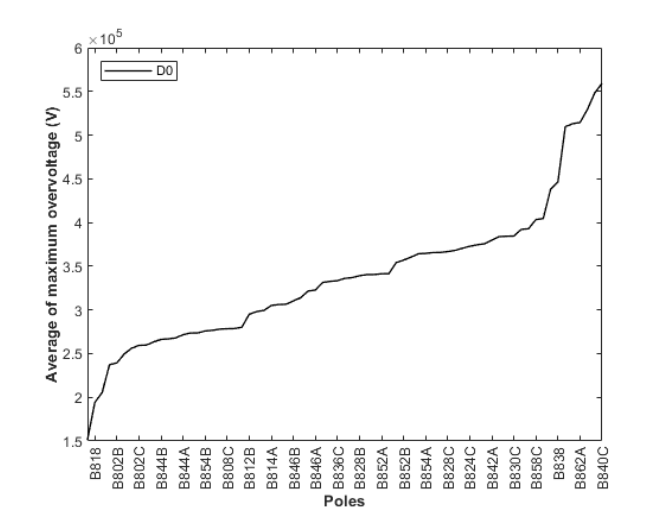
Figure 18. Average of the maximum overvoltages for each pole for the base case with m = 1 and n =